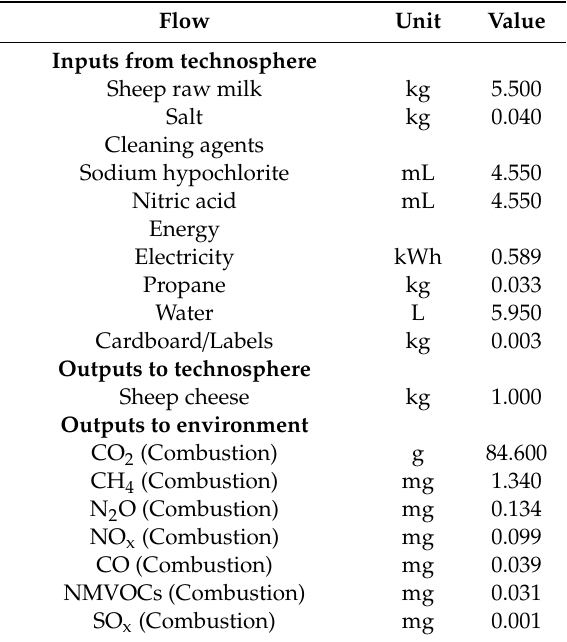
Table 2. Inventory data of 1 kg sheep cheese produced in the dairy factory.